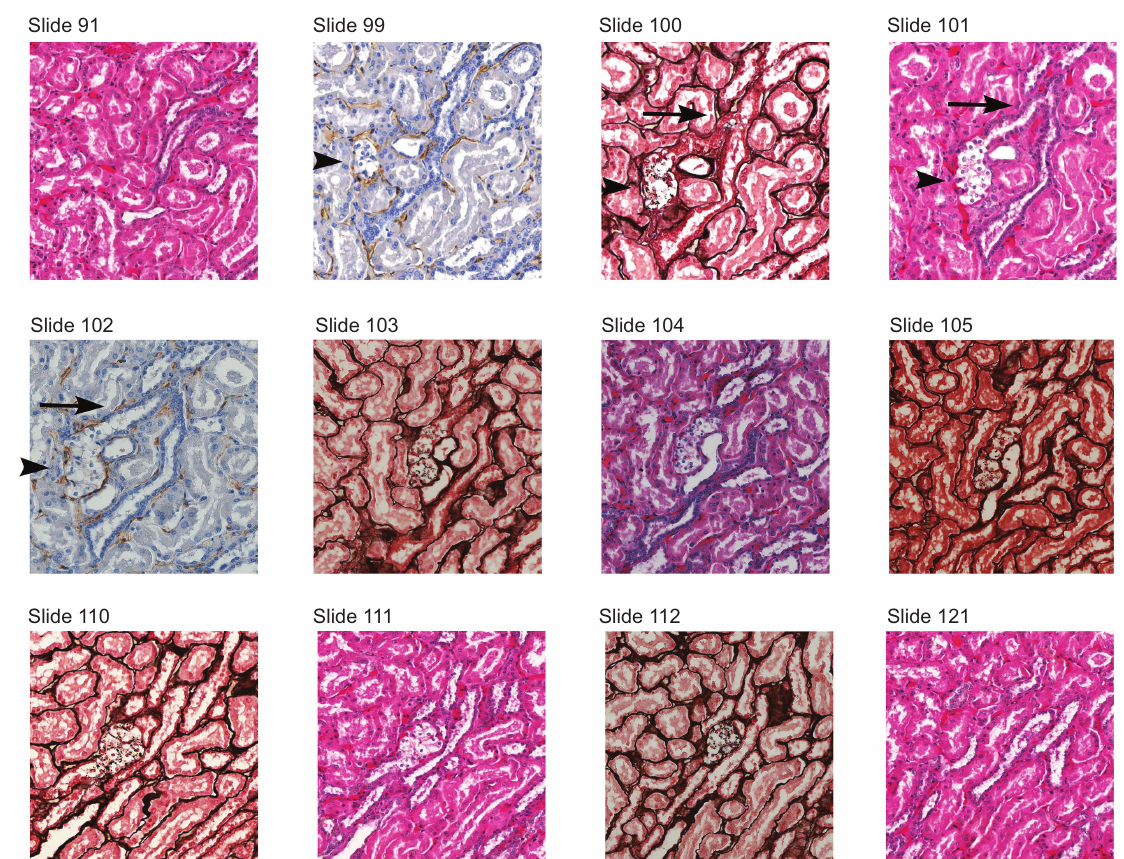
Figure 6: Selected images of 3D reconstruction of a single pathologic event in VHL kidney. The event was originally identified on slides #101 and #111 and classified as type D event (clear cell cluster). Consecutive unstained sections were used and variably stained for more detailed reconstruction. The event is contained between sections #91 and #121 which show no related patho- logic change. The event is characterized by a tubule obstructed by clear cells (demonstrated in sections #99 to #112). While the tubule is expanded by the clear cell proliferation, Jones special stain reveals intact tubular basement membrane (slides #100, #103, #105, #110, #112). Immunohistochemistry for CD31 shows increased capillarization in direct vicinity to the clear cell cluster (slides #99 and #102) as previously shown by Mandriota et